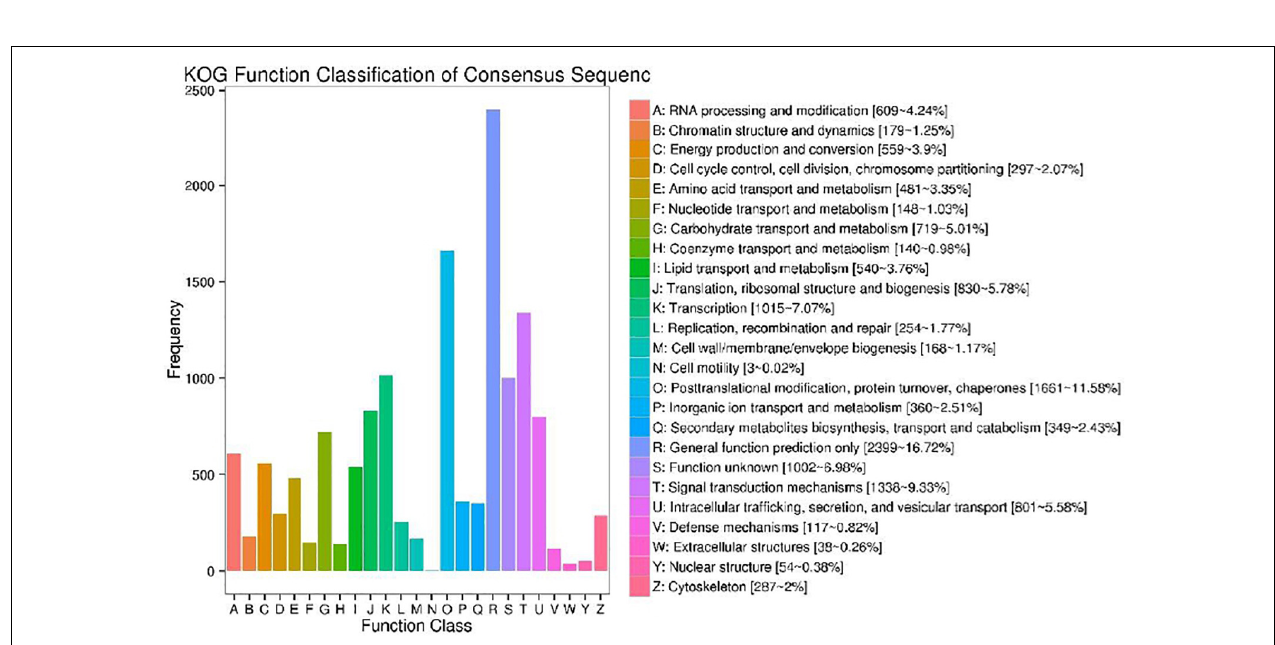
FIGURE 4 | Cluster of orthologous groups for enkaryotic complete genomes (KOG) classification. A total of 14,348 sequences with KOG classifications within the 25 categories are shown.